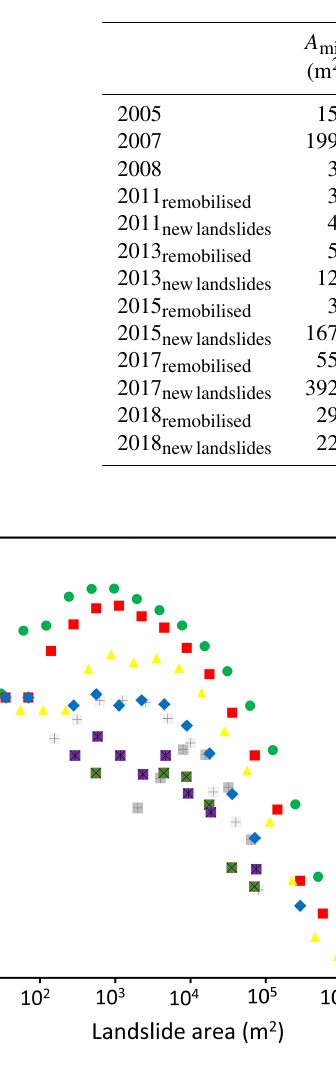
Figure 8. Frequency density–size distributions of pre-seismic land- slides (2005–2007), coseismic landslides (2008) and post-seismic remobilisations (2011–2018) in the landslide inventory. Note that the amount of data in 2007, 2017 and 2018 might be insufficient to delineate clear patterns and identify a roll-over